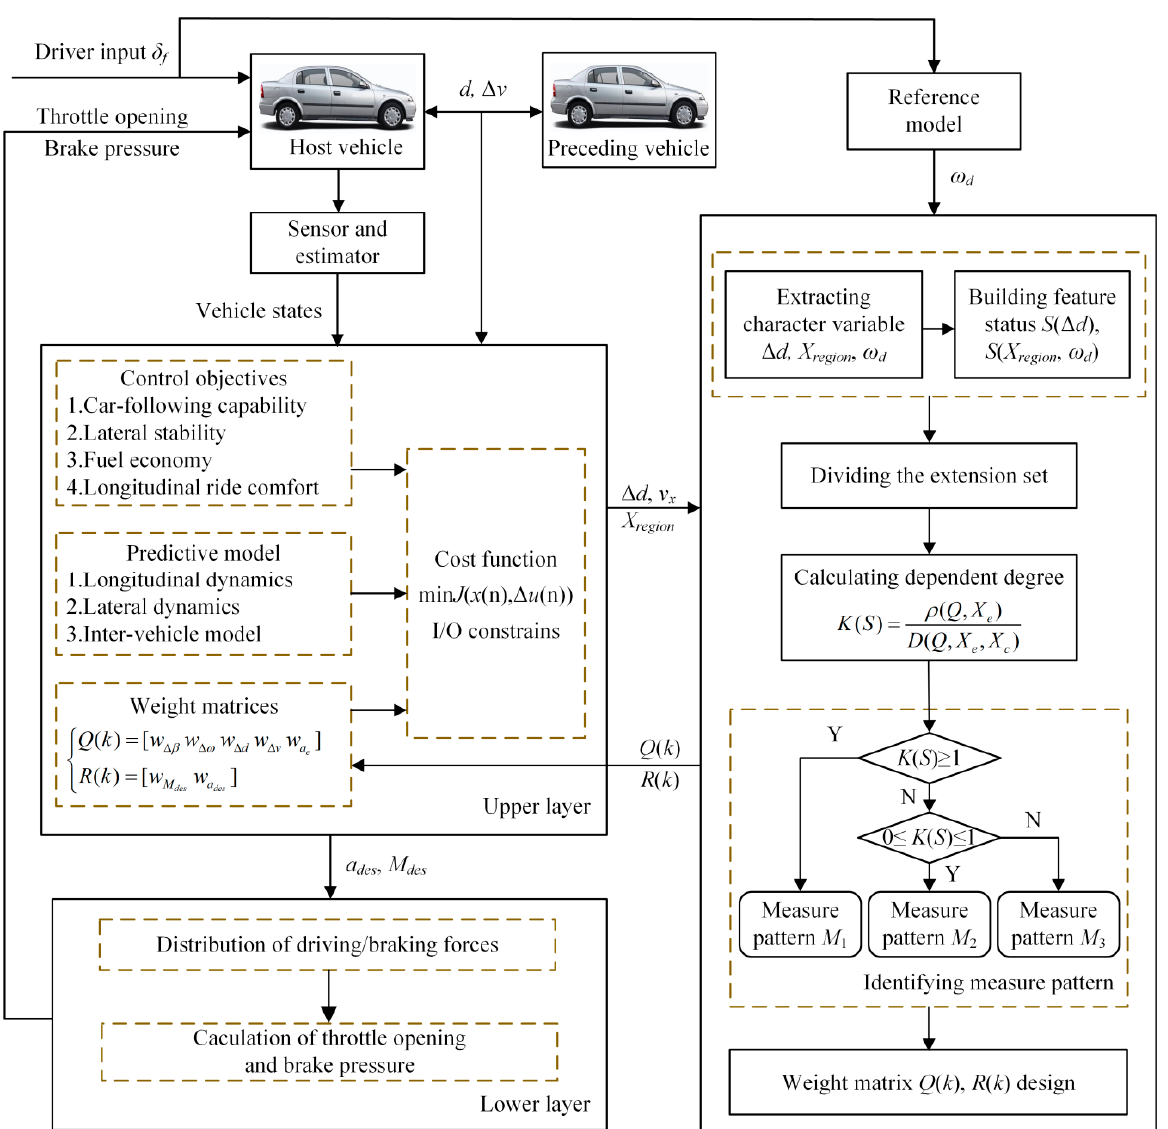
Figure 3. Framework of the proposed control.